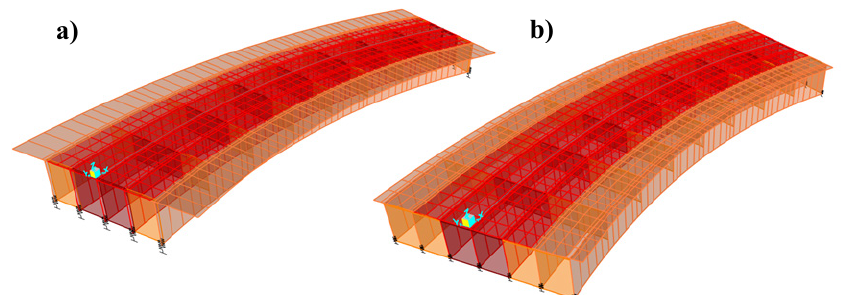
Figure 8. Three-dimensional finite element bridge model adopted in the analysis: (a) 5-girder model; (b) 7-girder model.